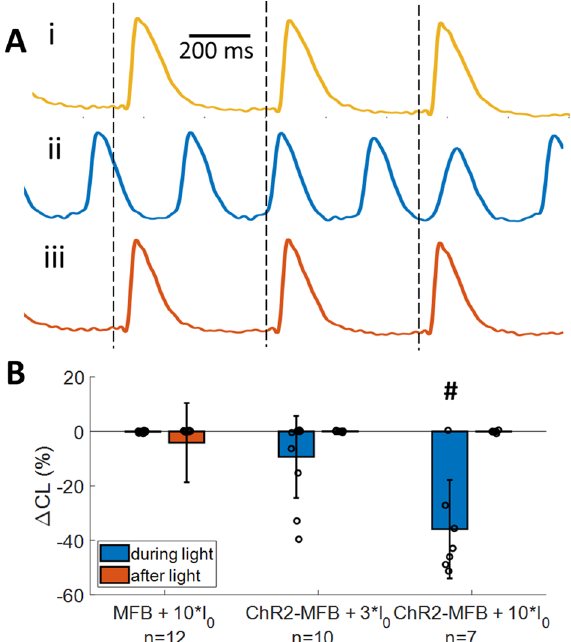
Figure 2. Inward current in myofibroblasts causes spontaneous beating in co-cultured cardiomyocyte syncytia. ( A ) Averaged voltage traces of a co-culture of ChR2-transduced MFBs (ChR2-MFBs) with CMs before (i, gold), during (ii, blue), and after (iii, orange) application of 10*I 0 blue light (I 0 = 0.0057 mW/mm 2 , the lowest light intensity at which functional effects were generally observed) to activate ChR2 current in MFBs. Vertical dashed lines show time of pacing. Activation maps are shown in Supplementary Fig. 2. ( B ) Percent change (from value prior to light application) in cycle length (CL) during and after application of light at different power levels during 500 ms CL pacing, for co-cultures of CMs with MFBs or ChR2-MFBs. 4/10 samples beat spontaneously at 3*I 0 , while 6/7 beat spontaneously at 10*I 0 . # indicates p < 0.005 between ChR2-MFB and MFB co-culture responses during